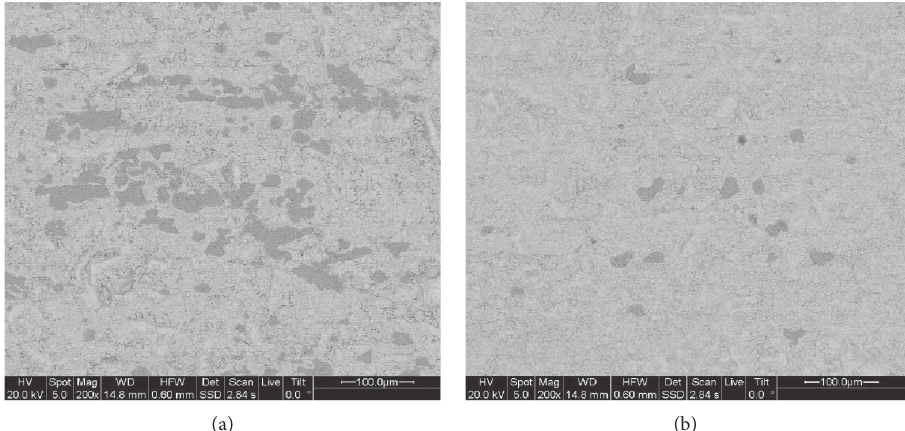
Figure 5: SEM surface images after static pickling in H